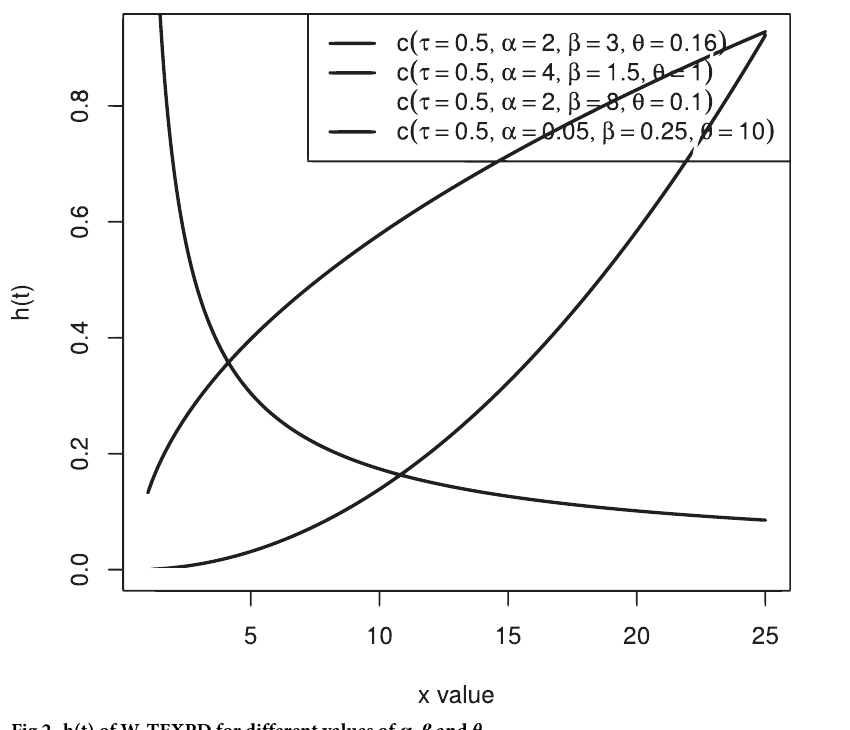
Fig 2. h(t) of W-TEXPD for different values of α , β and θ